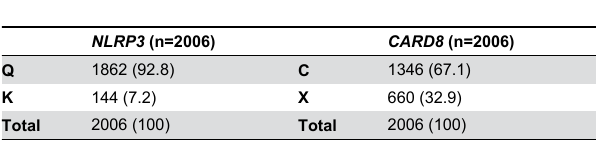
Table 2. Allele frequencies (%) in controls (n=2006) of the polymorphism C10X (rs2043211) in the CARD8 gene